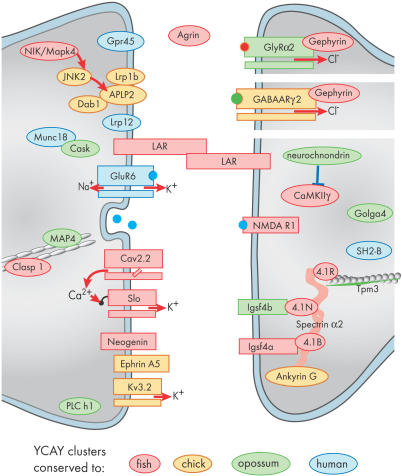
Conservation of YCAY Cluster Can Provide Insight into Evolution of Functionally Coherent Coregulated NetworkThe diagram shows a subset of proteins encoded by Nova-regulated transcripts for which we were able to obtain orthologous sequences for analysis of YCAY cluster conservation. The color coding represents the evolutionarily most distant species from mouse that contains a conserved YCAY cluster. High YCAY cluster conservation is seen in RNAs encoding adhesion and cytoskeletal scaffold proteins, ion channels, and signaling proteins. In comparison, RNAs with lower YCAY cluster conservation (limited to mammals) most often encode neurotransmitter receptors (such as glycine [GlyRα2] and kainate [GluR6] receptors) and signaling proteins (such as neurochondrin, Lrp12, and Gpr45).